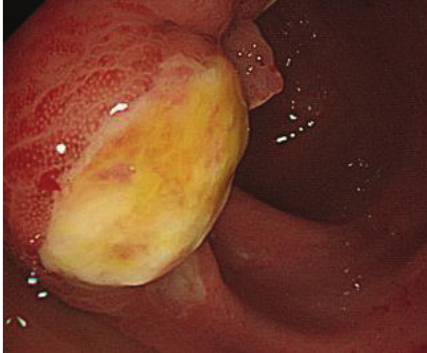
Figure 2: An ulcer on the ileum identified by